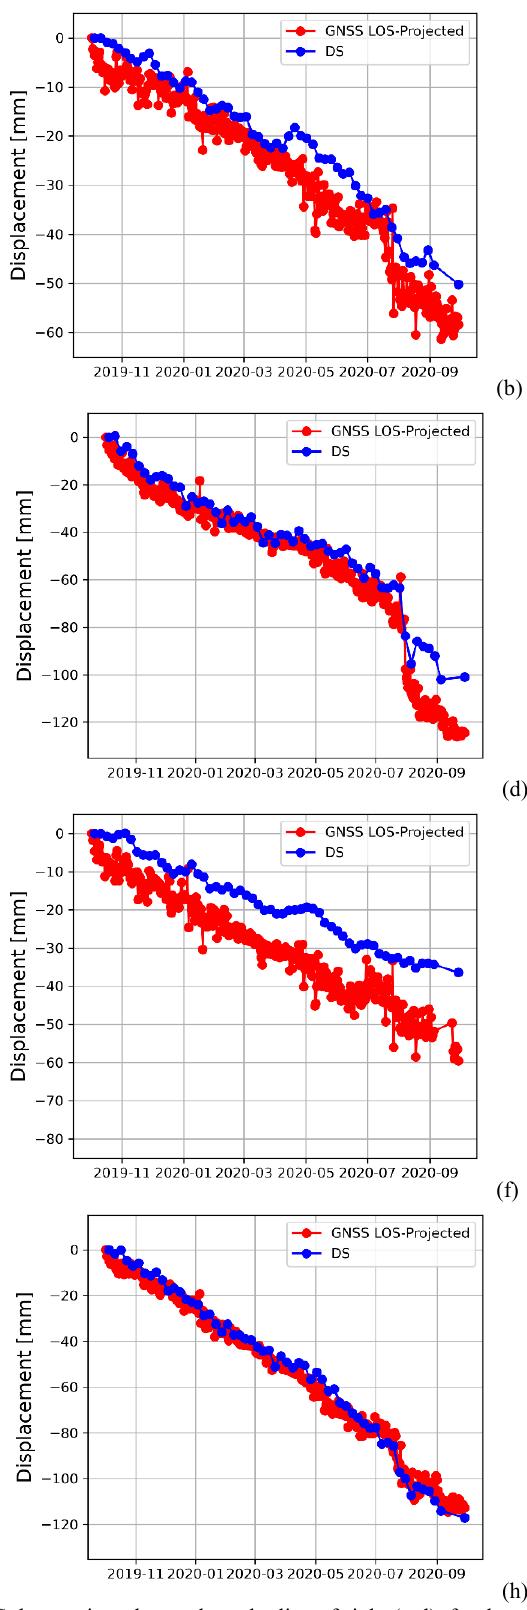
Figure 5 . Displacement time series comparing DS (blue) and GNSS data projected onto the radar line of sight (red), for the points in the proximity of the GNSS stations: ZHSR, asc (a) and (desc); PIES, asc (c) and desc (d); ZHPR, asc (e) and desc (f); WYZY, asc(g) and desc